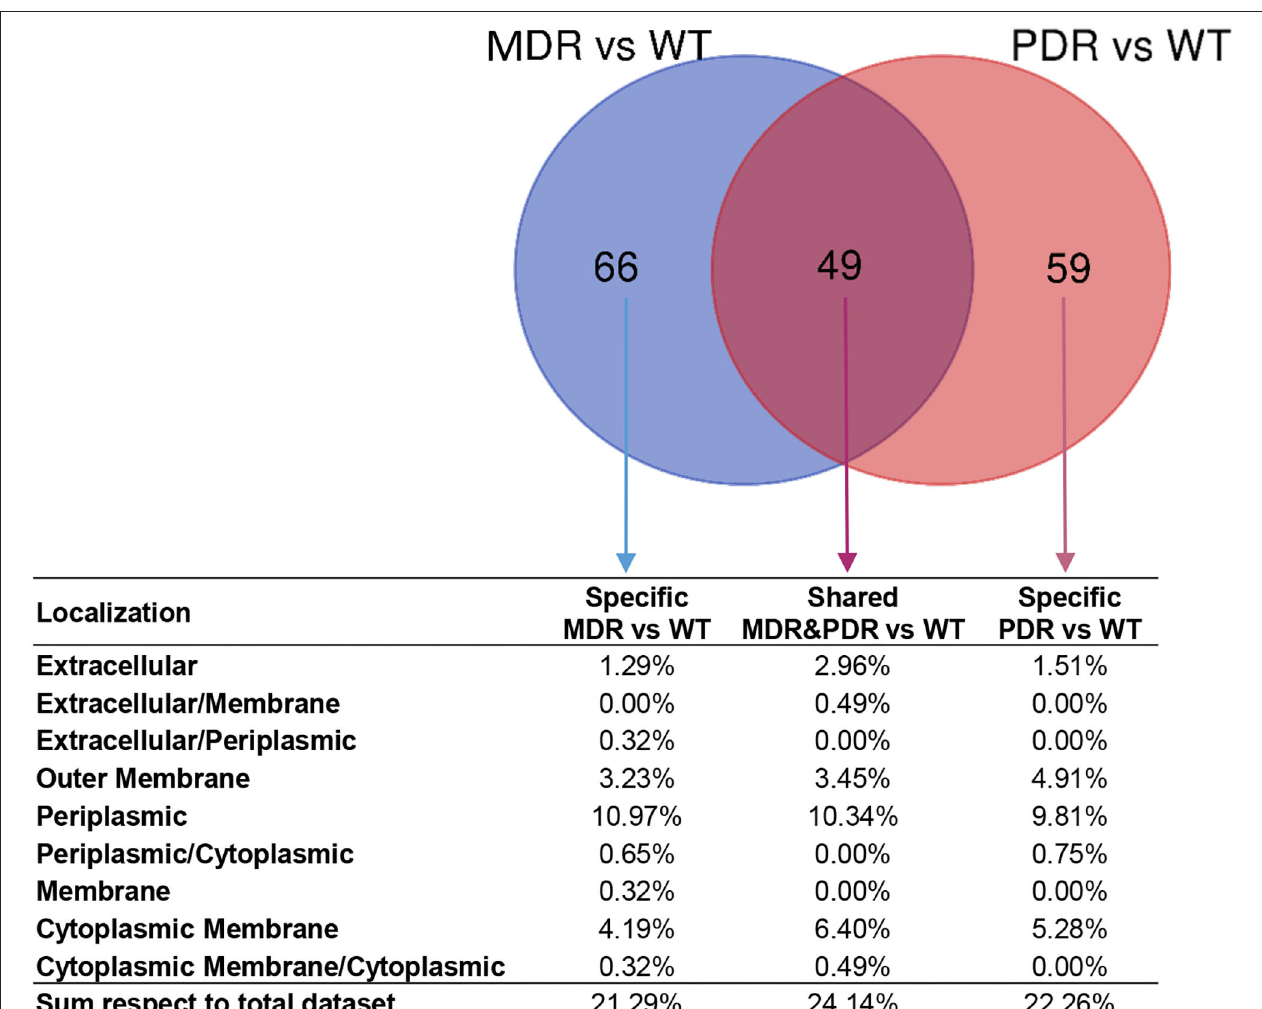
FIGURE 4 | Venn diagram showing common and specific non-cytosolic (extracellular space, cell surface, outer membrane, periplasmic region, and cytoplasmic membrane) proteins in MDR vs. WT (119 total proteins) and PDR vs. WT (108 total proteins) comparisons based on label-free quantification. Percentages of the distribution among the different subcellular regions, respect the total quantified proteins, are reported below each subset of the diagram.